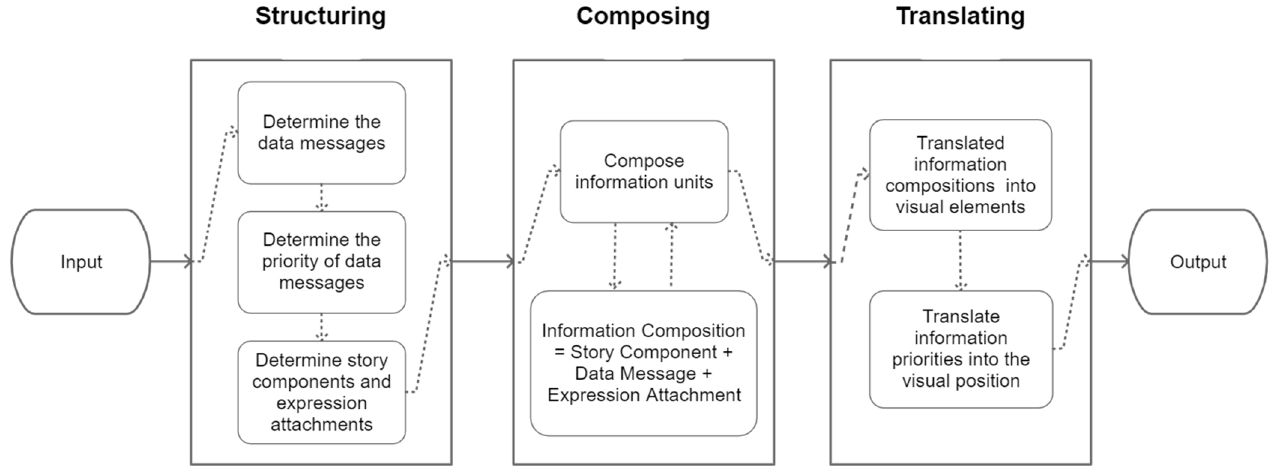
Figure 10. Major phases of information processing: structuring, composing, and translating.